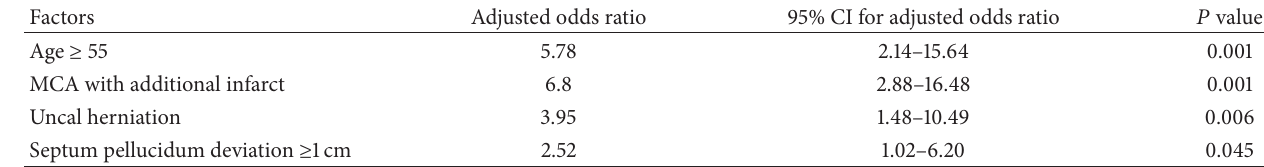
Table 2: Multivariate analysis of factors impacting outcome [mRS ≤ 4 versus > 4].